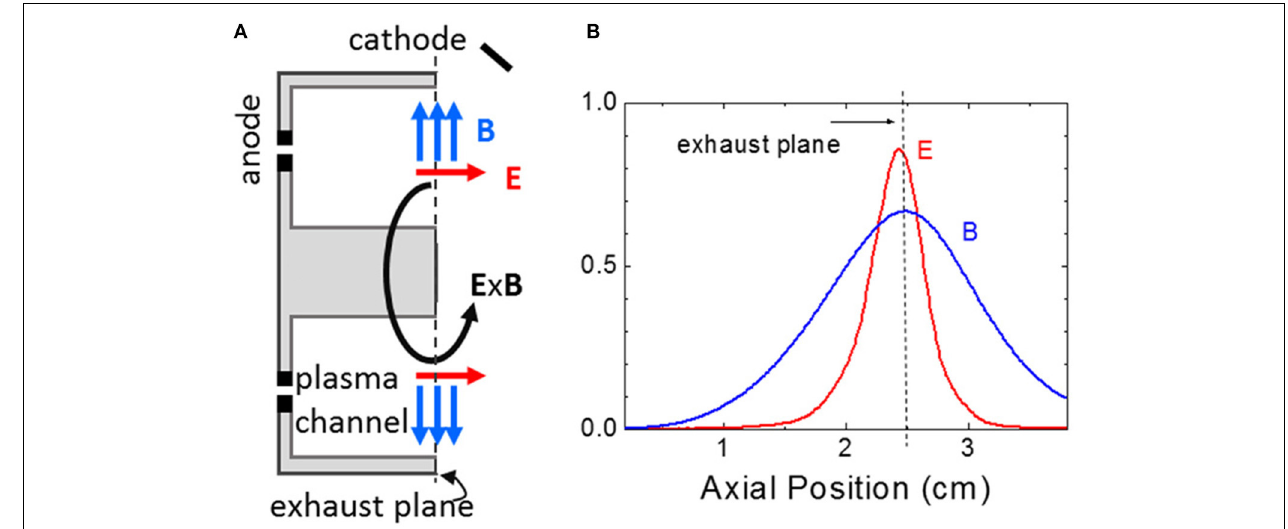
FIGURE 12 | (A) Schematic of a Hall thruster. The plasma is generated between two concentric dielectric cylinders. The magnetic barrier is generated in the exhaust plane by a system of coils and a magnetic circuit; (B) axial profiles of the external radial magnetic field and of the